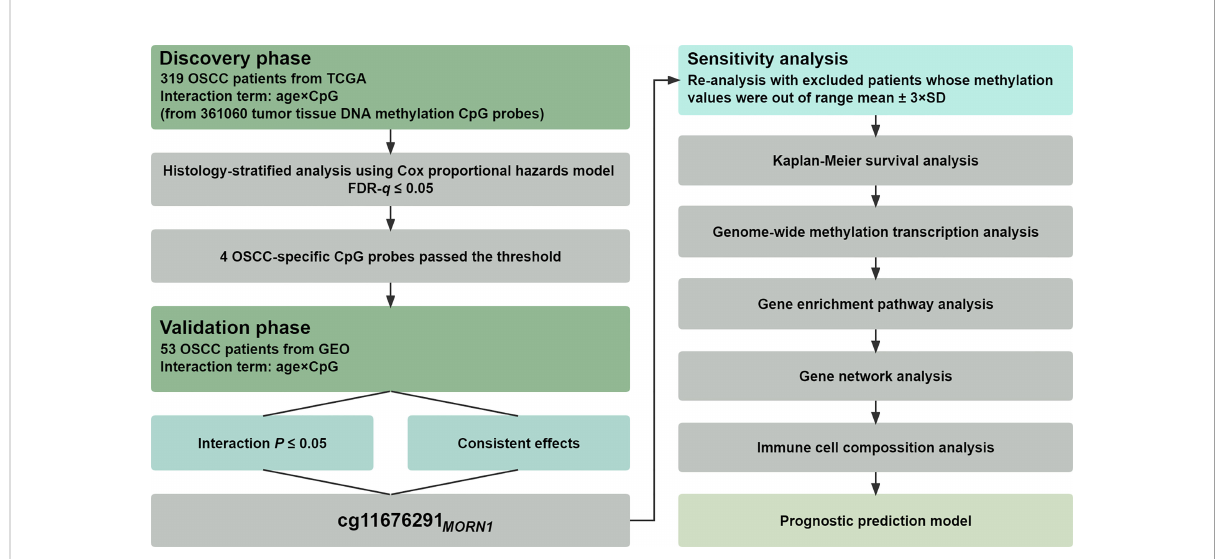
FIGURE 1 Flow chart of study design and statistical analyses. Patients from TCGA were used in the discovery phase for biomarker screening, whereas patients from the GEO were used for biomarker